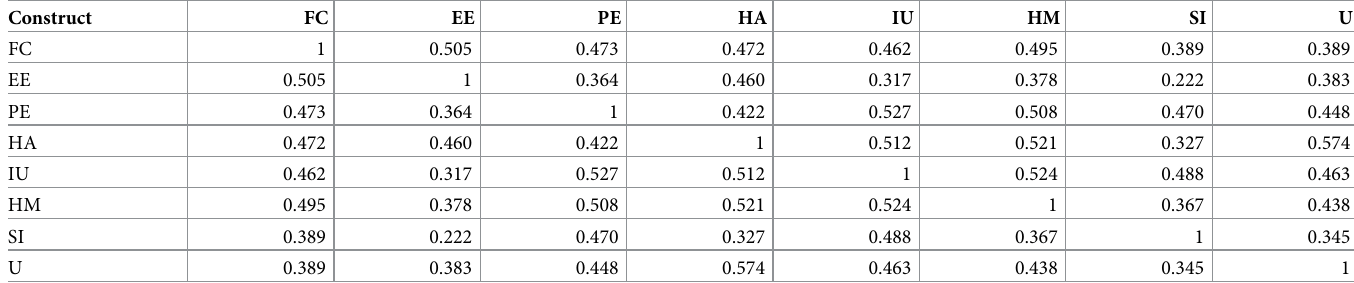
segments: the independent elder, the technological-apathetic elder, and the technological- eager elder. These three segments are subsequently used in the PLS-MGA to compare the path coefficients. Step 2: Estimate the PLS-SEM models associated with the previously determined seg- mentation. Table 10 shows the path coefficients, R 2 and Q 2 , for each segment (details of anal- yses by segments in S2 File). In the “independent elder” segment, PE and HA explained the intention to use SNS. In the segment labeled “technological-apathetic elder,” PE, HA, and SI explained the intention of use. Finally, for the users in the segment marked as “technological- eager elder,” SI, HM, and HA explained the intention of use. HA is important in all three seg- ments to explain the intention to use but at different levels. On the other hand, PE is important in the first two segments, and SI is important in the latter two segments to explain this intention. Table 7. Correlations.